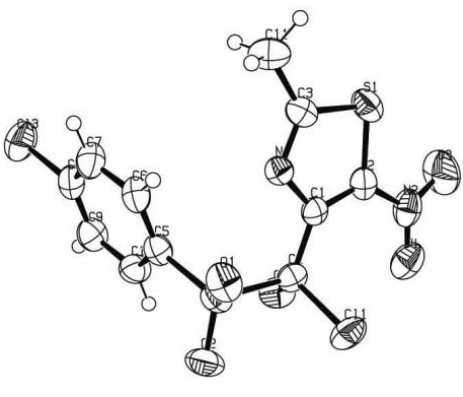
Figure 1. X-Ray structure of compound 3c